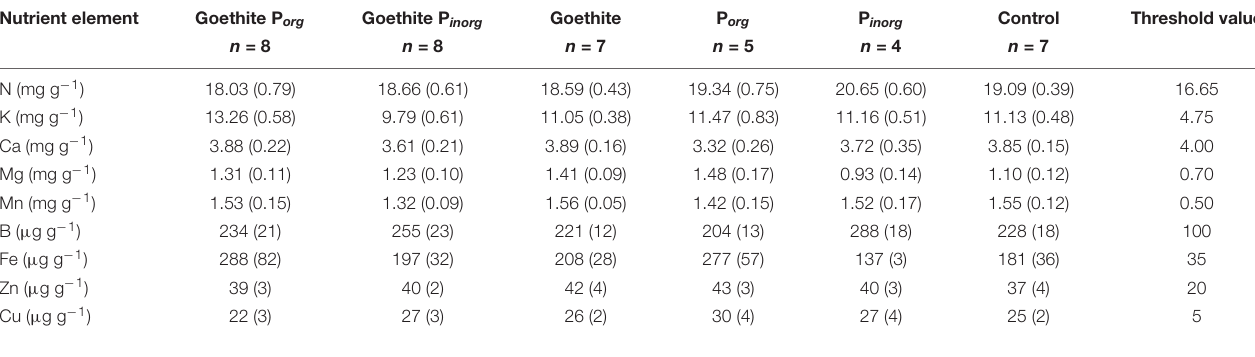
TABLE 5 | Contents of essential nutrient elements in leaves at the end of the experiment in comparison to threshold values for deficiency level (Göttlein, 2015). Nutrient